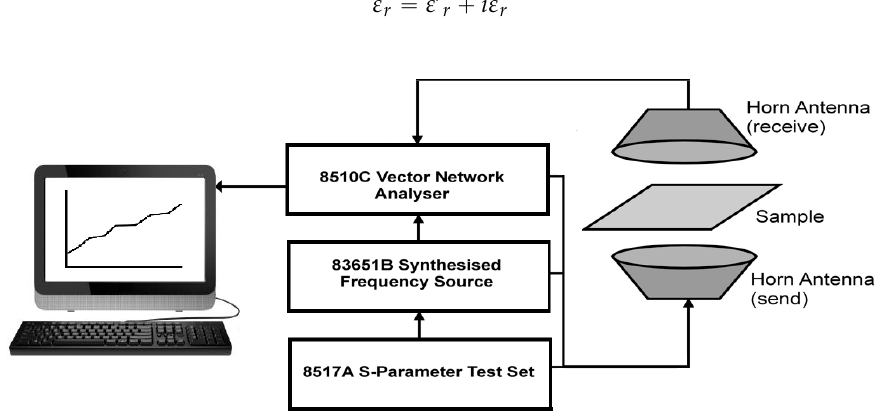
Figure 3. Schematic of free space transmission set-up.